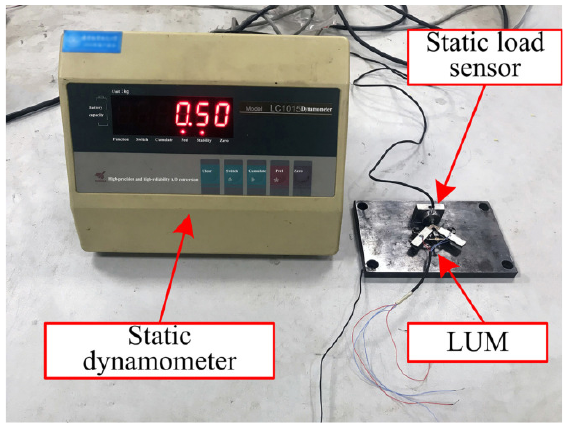
Figure 16. Experimental setup for measuring static contact force.